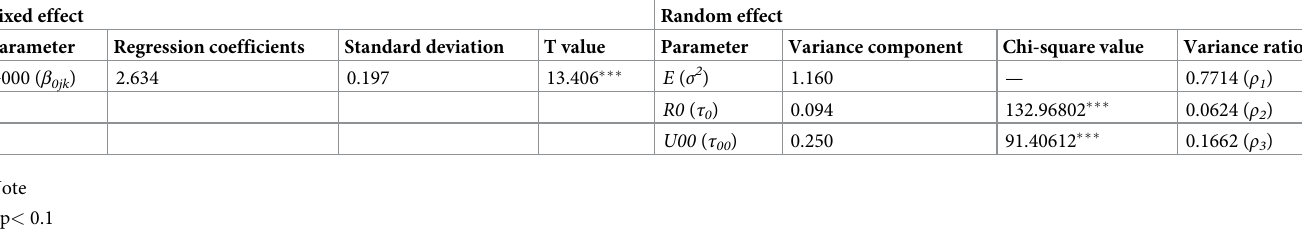
Table 5. Calculation results of the null